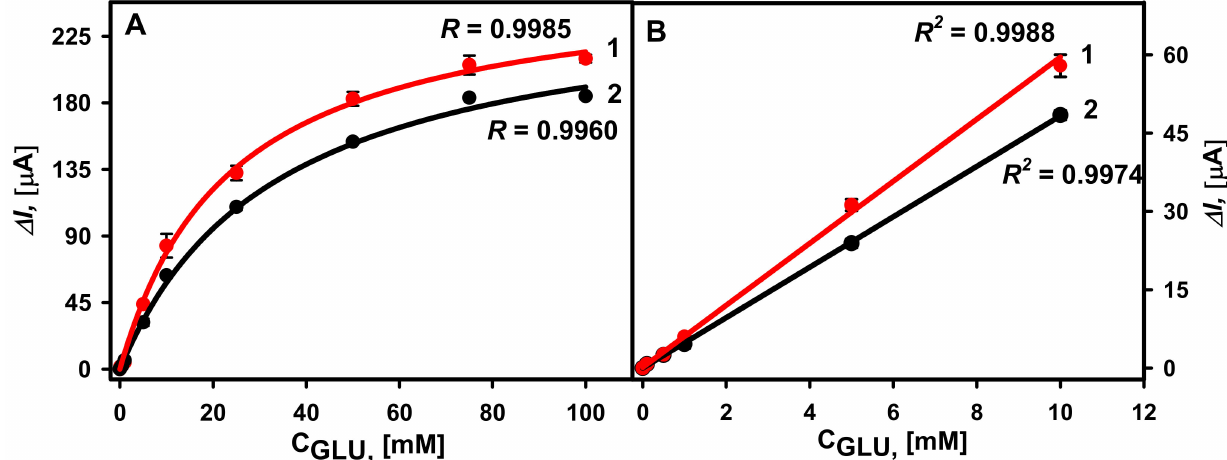
Figure 6. ( A ) Calibration plots of glucose biosensors based on GA-GOx-SAM/DGNs/GR (curve 1, red dots • ) and GA-GOx/DGNs/GR (curve 2, black dots • ) electrodes in serum. ( B ) The linear glucose detection range. The amperometric response at +0.3 V was registered in 0.05 M SA buffer with 0.1 M KCl (pH 6.0) diluted serum in the presence of 6.0 mM PMS.